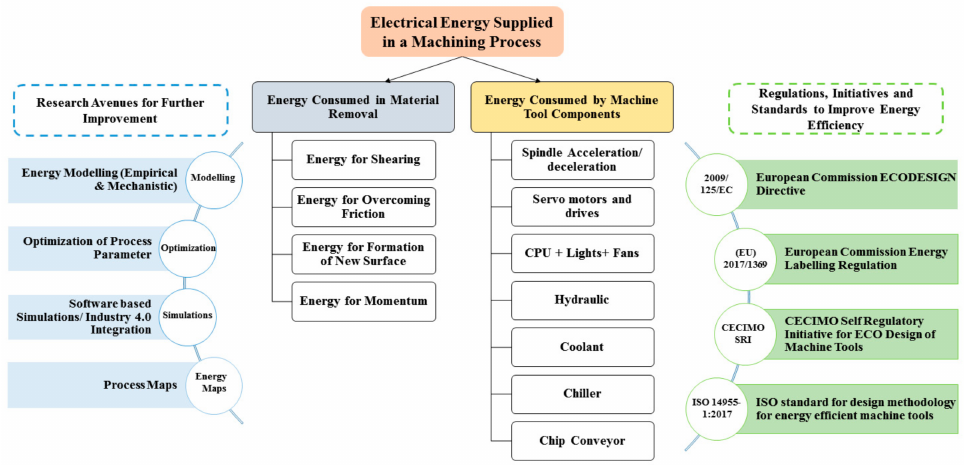
Figure 1. Energy consumed in a machining